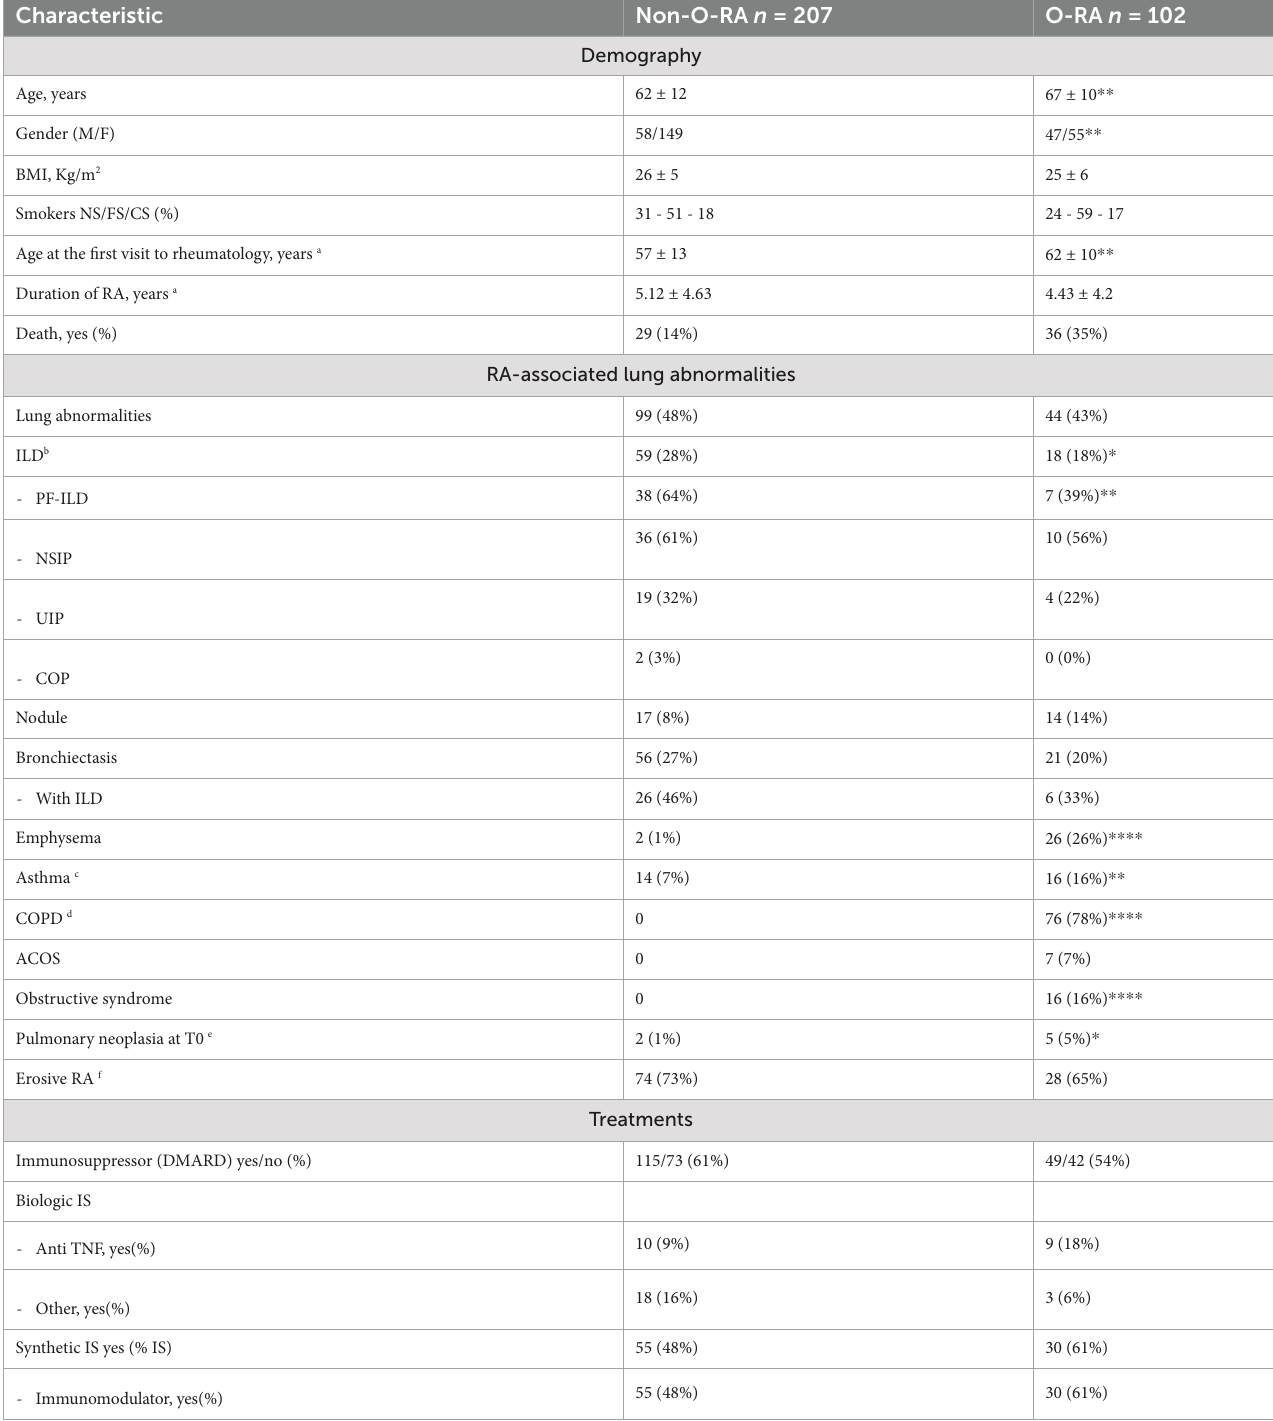
TABLE 1 Patient